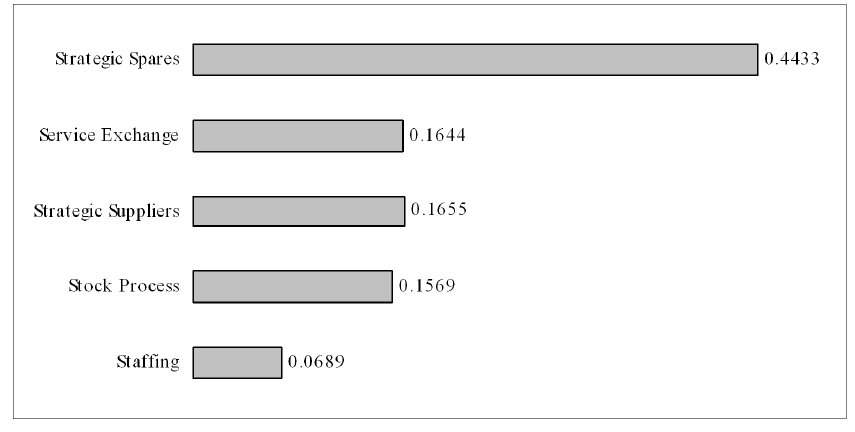
Figure 5: Overall risk of audit projects.